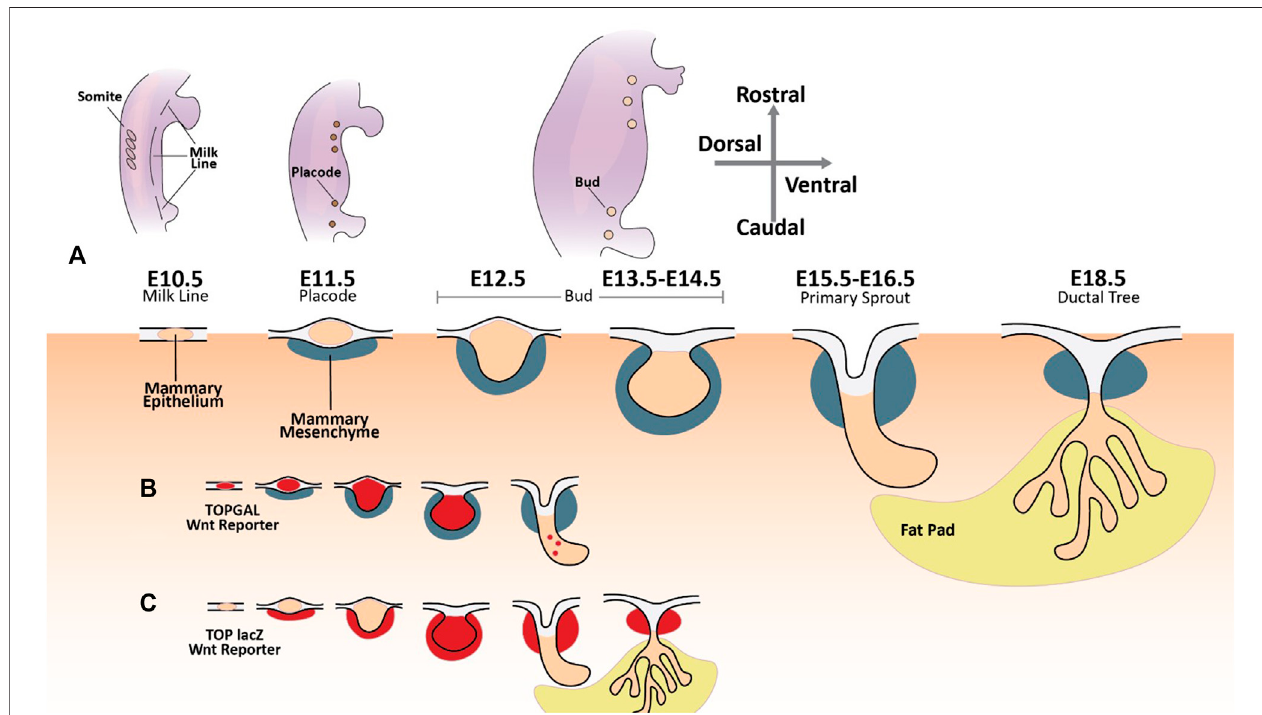
FIGURE 3 | The developing mammary gland and Wnt signaling activity. (A) The fi rst morphogenic event in murine mammary gland embryonic development is the speci fi cation of the mammary lines along the anterior-posterior axis of each fl ank around embryonic day 10.5. On embryonic day 11.5, fi ve pairs of placodes composed of condensed mammary epithelial cells arise from the mammary line. These primordial structures undergo a series of morphological changes until a rudimentary mammaryductaltreeisformedatE18.5. (B) TOPGALWntreporterexpressionduringembryonicmammaryglanddevelopment(Wntactiveareasinred)(Chuetal., 2004). (C) TOP lacZ Wnt reporter expression during embryonic mammary gland development (Wnt active areas in red) (Boras-Granic et al., 2006; Boras-Granic and Wysolmerski,